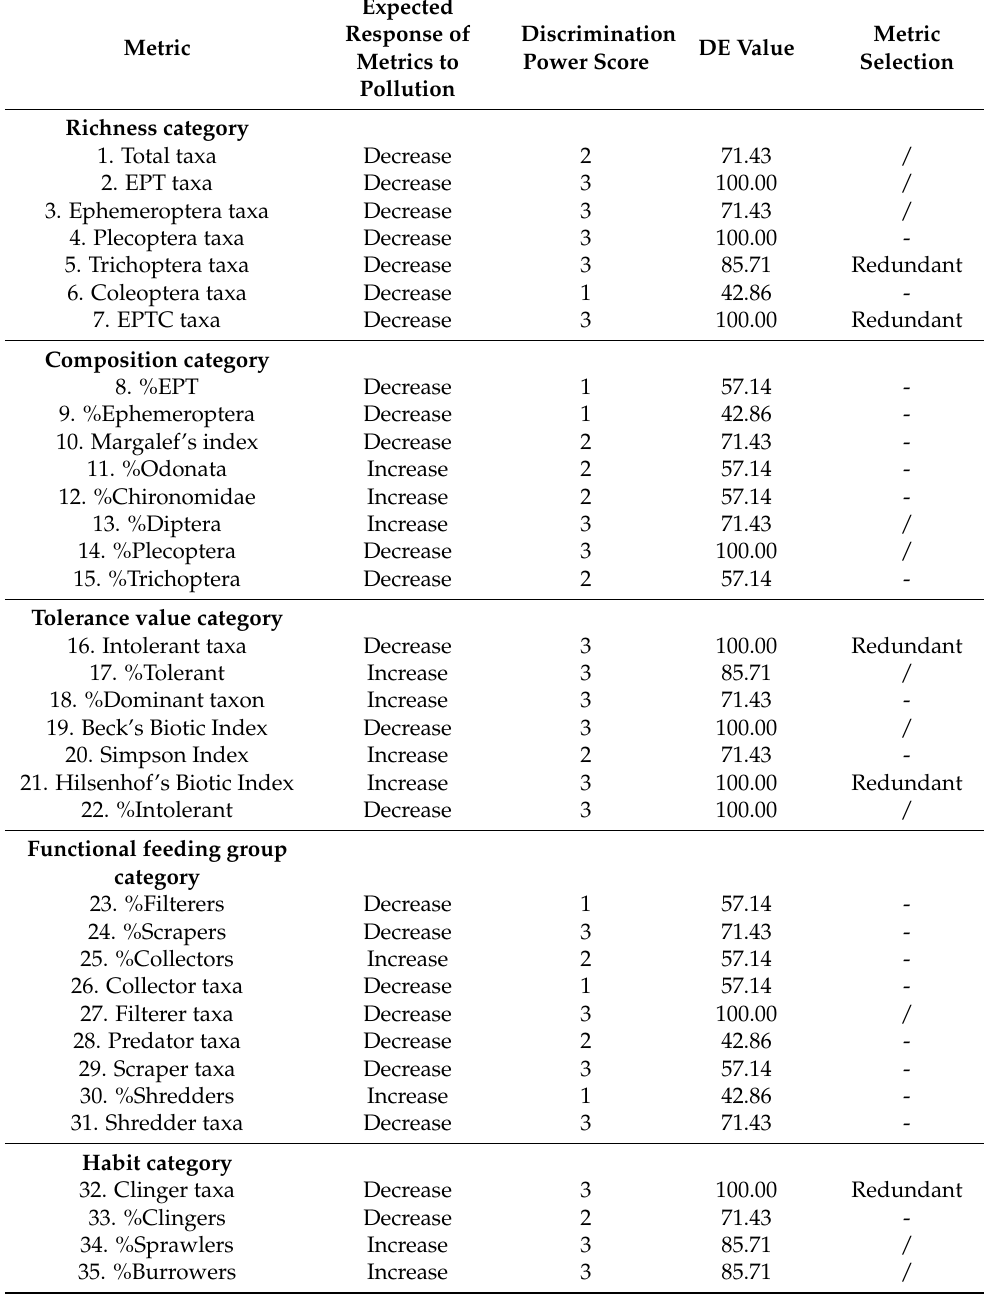
Table 5. Thirty-five candidate metrics selected for the development of MMI and their predicted response to disturbance or pollution, discrimination power score, and DE value. Metrics that met or did not meet the test criteria are expressed as symbols (/) and (-),